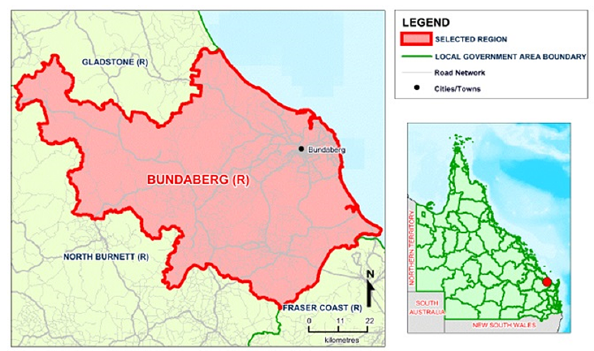
Figure 1. Map of Bundaberg Regional Council (Queensland Gov- ernment,